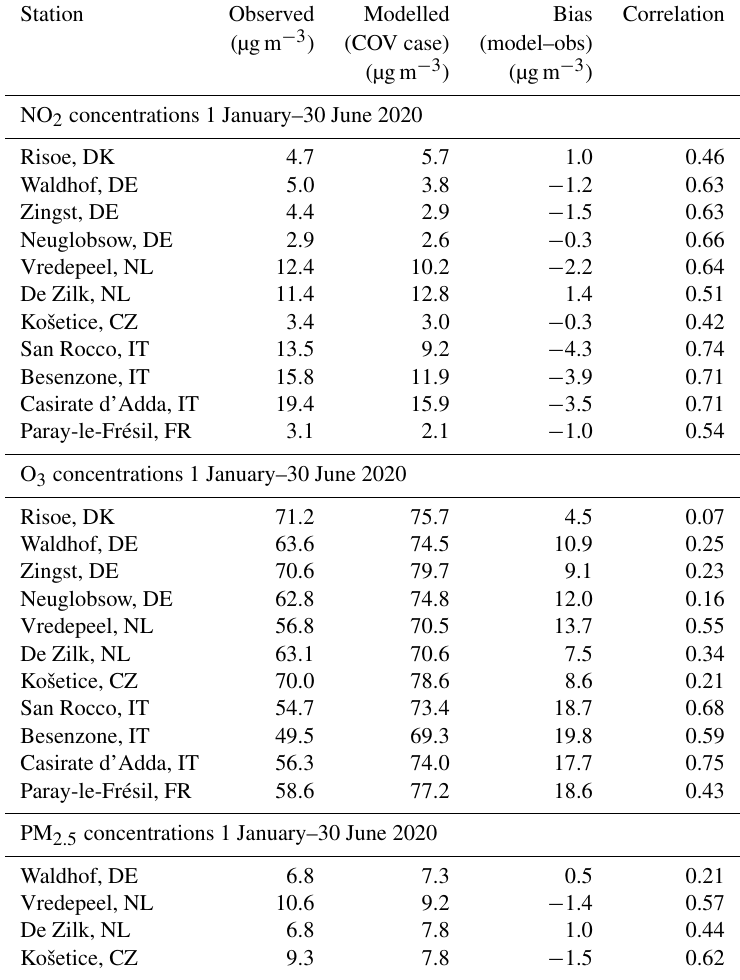
Table 1. Statistical evaluation of a comparison between observations of NO 2 at selected background stations of the EEA network with CMAQ model results between 1 January and 30 June 2020. Station Observed Modelled Bias Correlation (µgm − 3 ) (COV case)